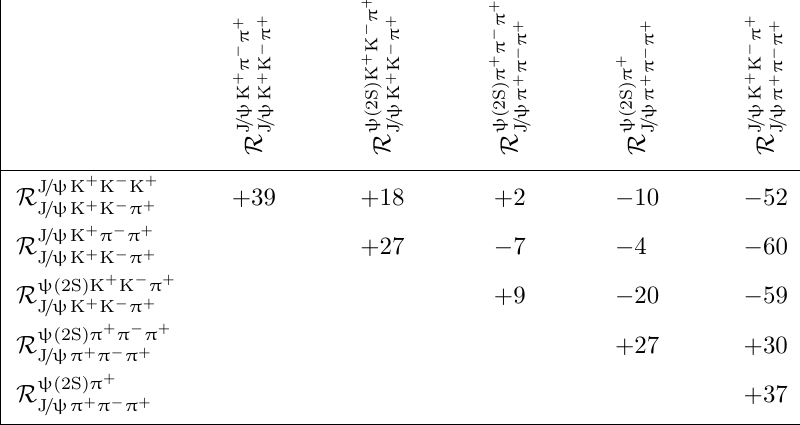
Table 8 . Off-diagonal correlation coefficients ( [%] ) for systematic uncertainties for the measured ratios R X Y